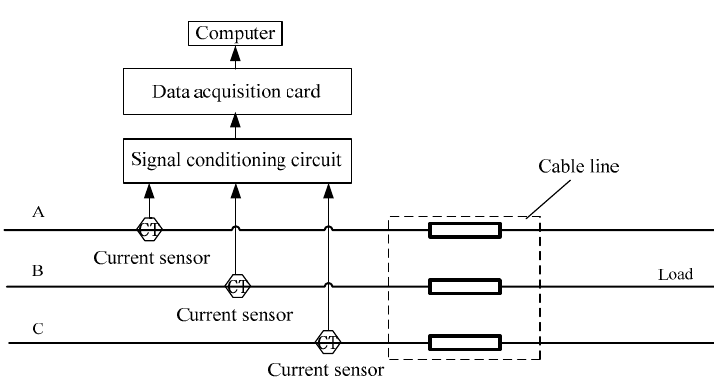
Figure 6. Experimental system structure.